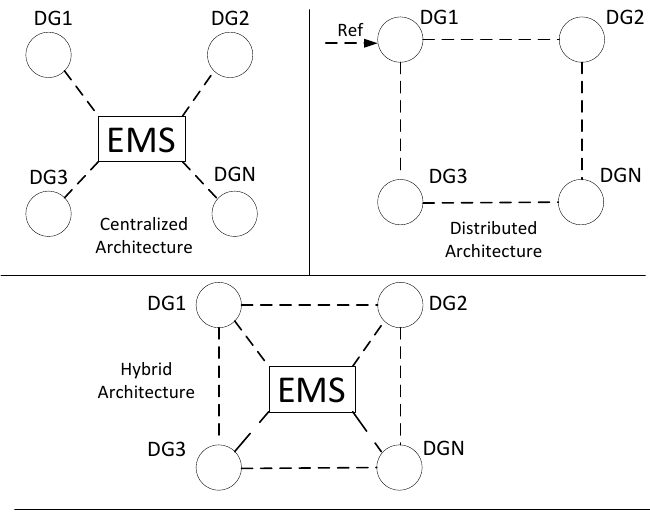
Figure 4. Communication architectures for power sharing control